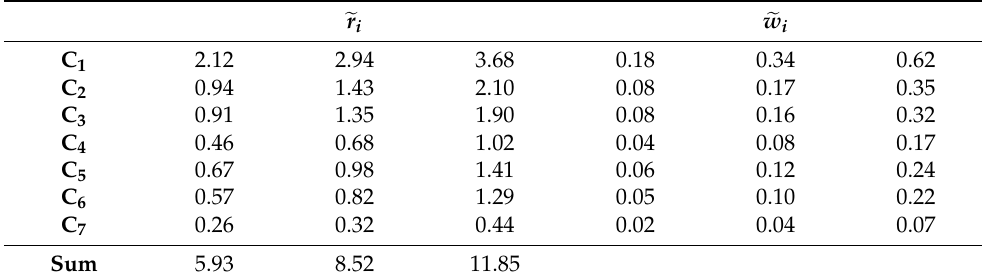
Table 7. Results of the (cid:101) r i and (cid:101) w i